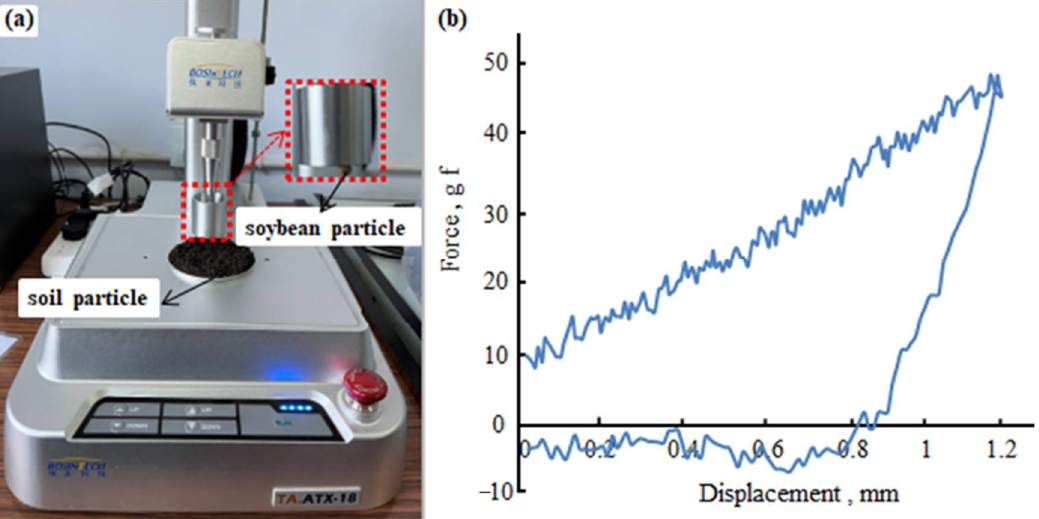
Figure 1. ( a ) Texture analyzer, and ( b ) the relationship between force and displacement of the probe. The relationship between force and displacement of the probe is shown in Figure